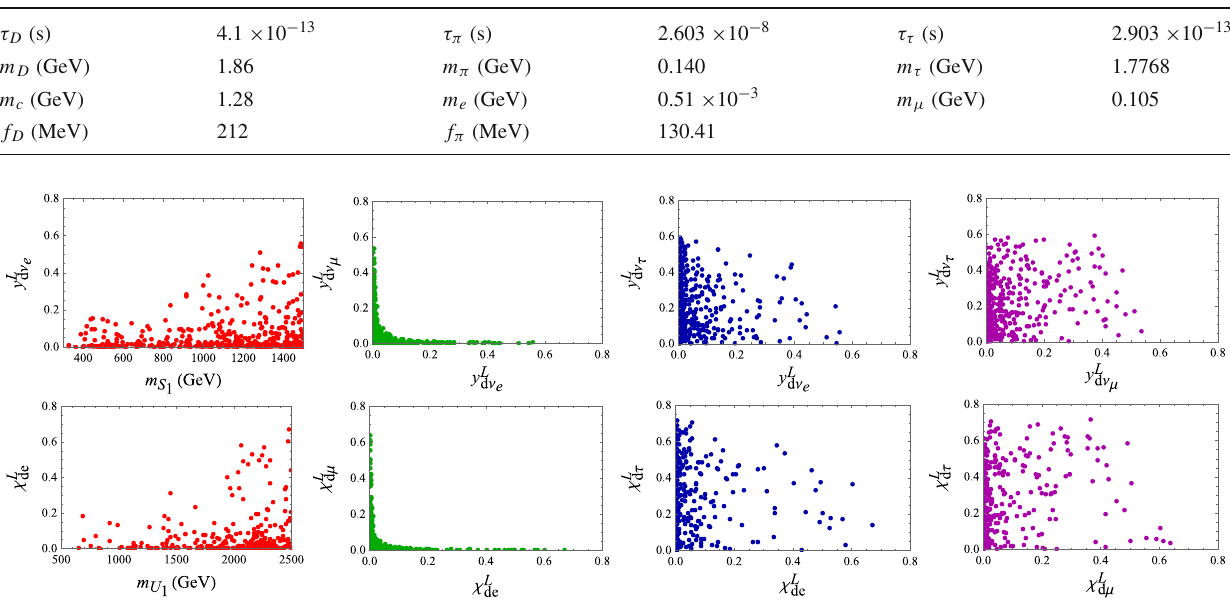
| = ( 1 . 2327 ± 0 . 0023 ) × exp e /μ | = ( 1 . 2352 ± 0 . 0001 ) SM e /μ